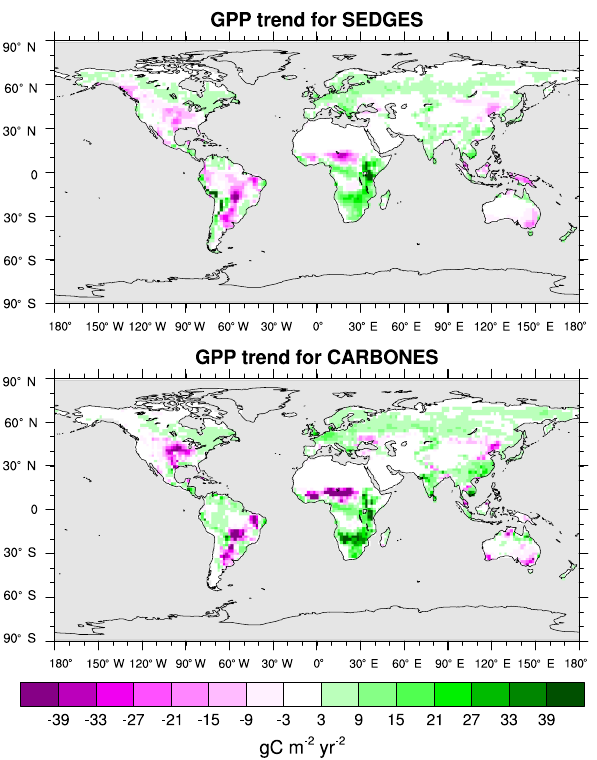
Figure 11. Vegetative carbon for SEDGES: mean over 1981–2010 in the transient CO 2 simulation; vegetative carbon from the Olson et al. (1985) reference dataset, which represents pre-Iron Age vege- tation save for the most extreme anthropogenic land cover